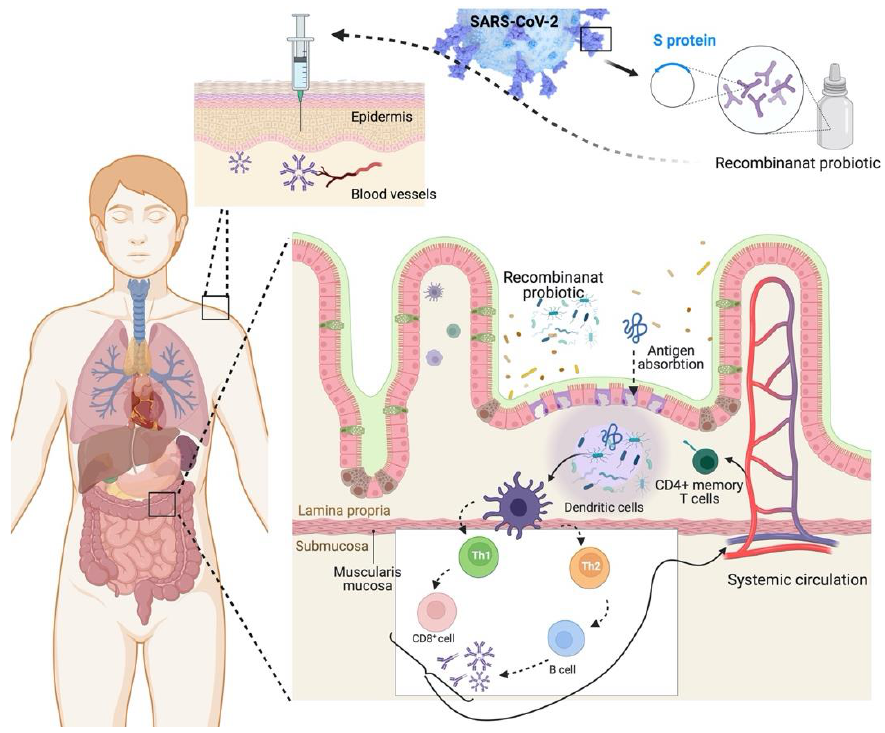
Figure 4. The possible scope of probiotics in vaccine development against viral infections.